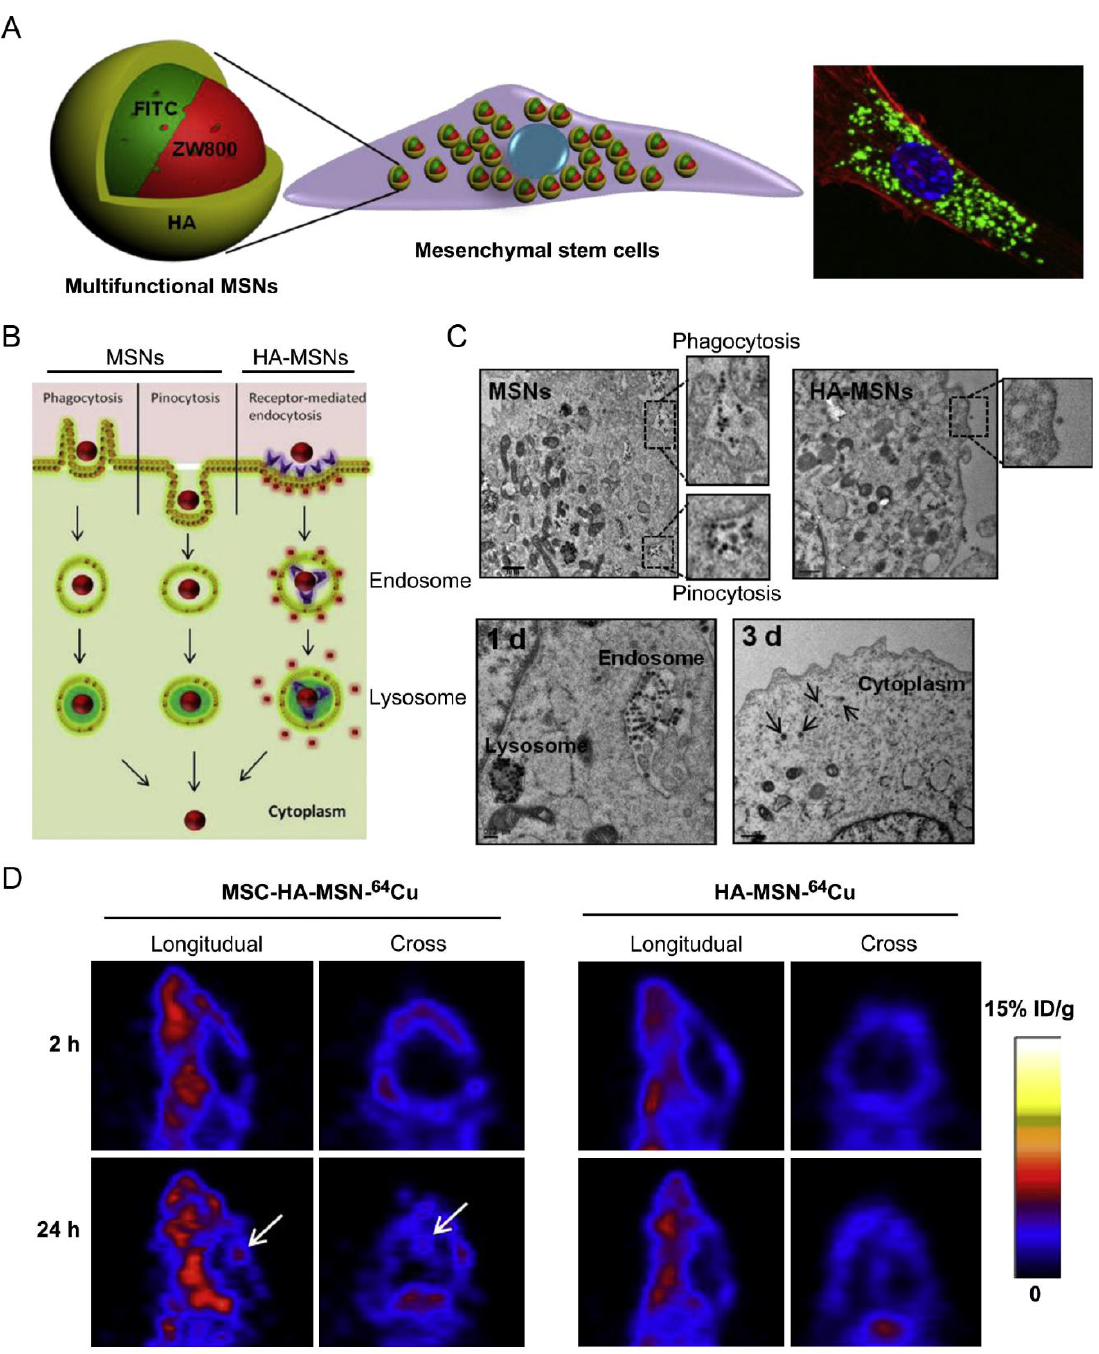
Figure 2. ( A ) Schematic of the structure of MSNs. ( B ) Schematic of the uptake mechanism. ( C ) TEM of the uptake mechanism. ( D ) PET imaging of the MSN-mediated tumor targeting. HA, hyaluronic acid-based polymer; MSNs, mesoporous silica nanoparticles; TEM, transmission electron microscopy; PET, positron emission tomography. Reprinted with permission from Ref. [28], Copyright © 2012 Published by Elsevier Ltd.